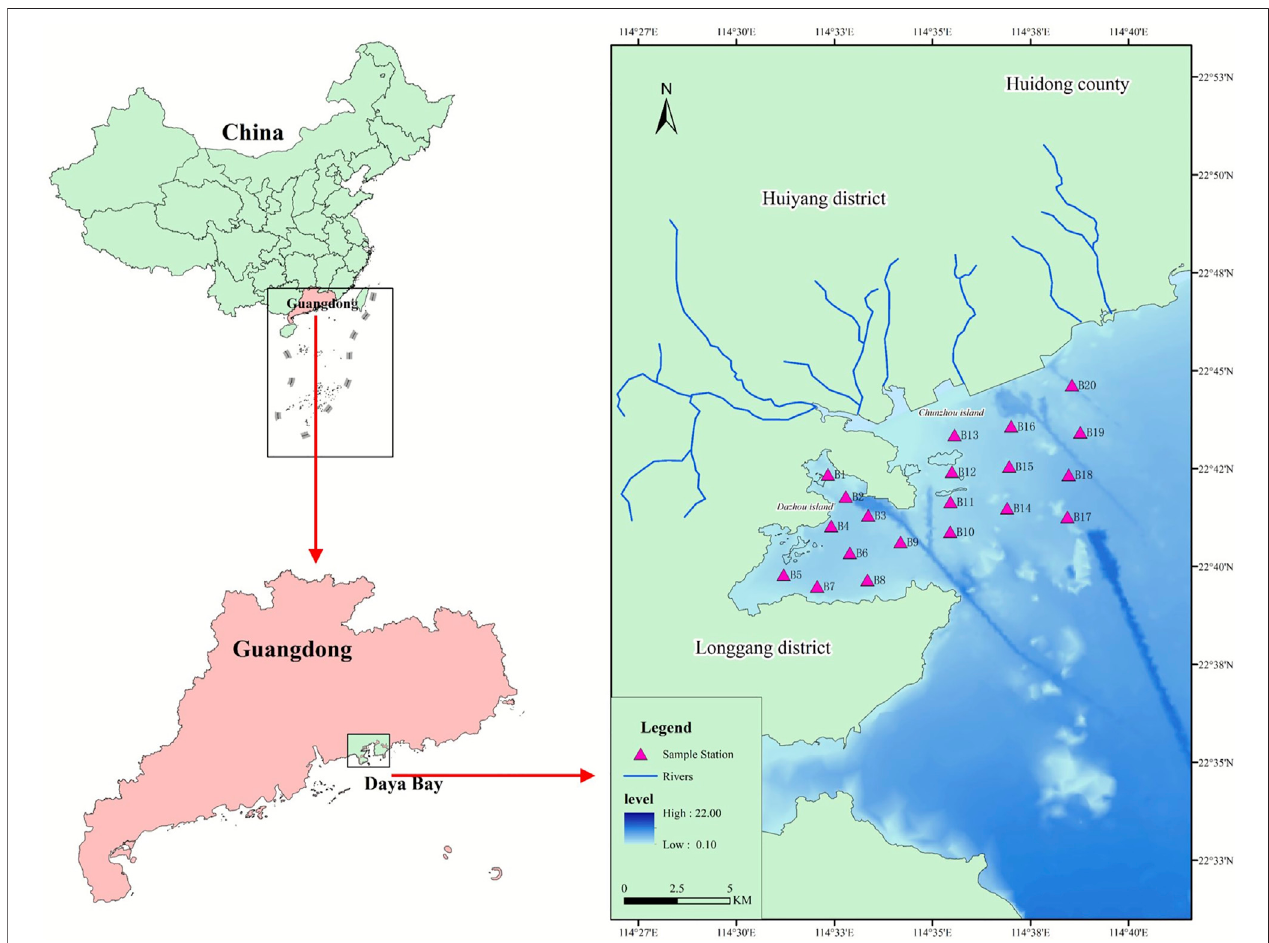
FIGURE 1 | Sampling sites of surface sediment in Daya